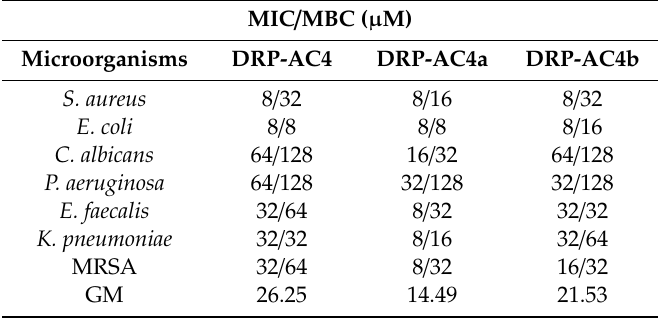
Table 3. Inhibitory and bactericidal effects of peptides on different microorganisms.